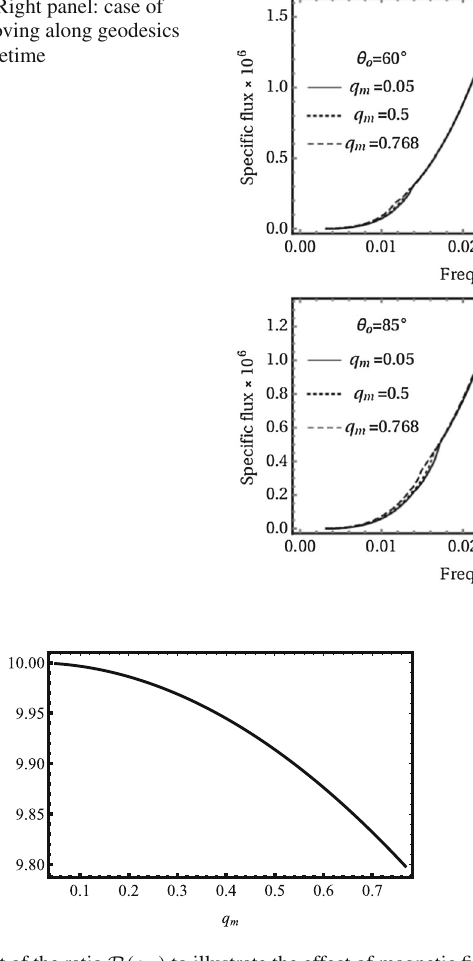
Fig. 7 Profile of spectral lines of radiation with local energy 6 . 4 keV , originated in the inner region of Keplerian disc. This region spans from r in = r ISCO to r out = 20 M . The plots are generated for three representative values of observer inclination θ o = 30 ◦ (top), 60 ◦ , and 85 ◦ (bot). Left panel: case of photons moving along geodesics of effective Bardeen geometry; Right panel: case of photons moving along geodesics of RN spacetime